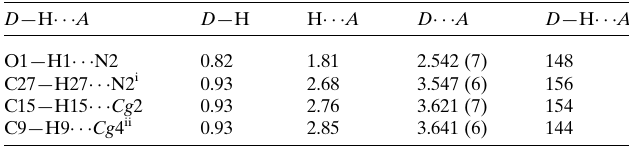
Table 2 Experimental details. Crystal data Chemical formula